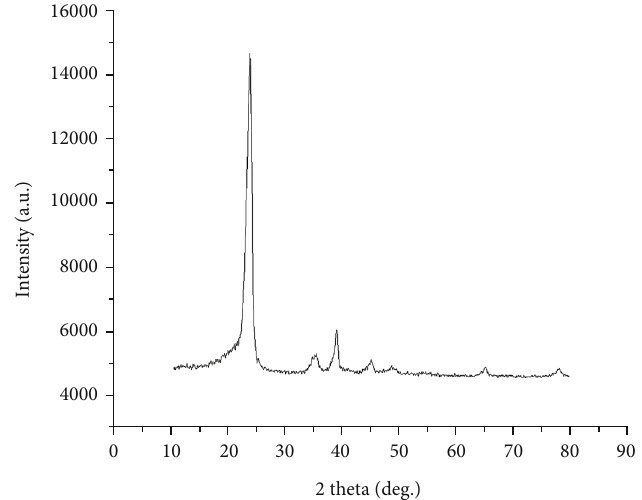
Figure 6: XRD spectrum of Ag/POM/ β -CD micro fi bers fi lm with 30 wt.% β